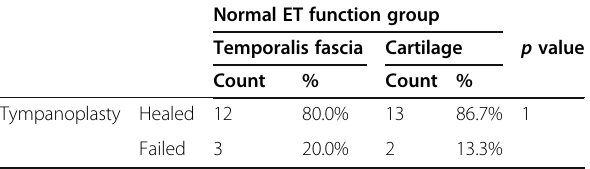
Table 3 Comparison between the tympanoplasty results using temporalis fascia graft and cartilage graft in the ET dysfunction group ET dysfunction